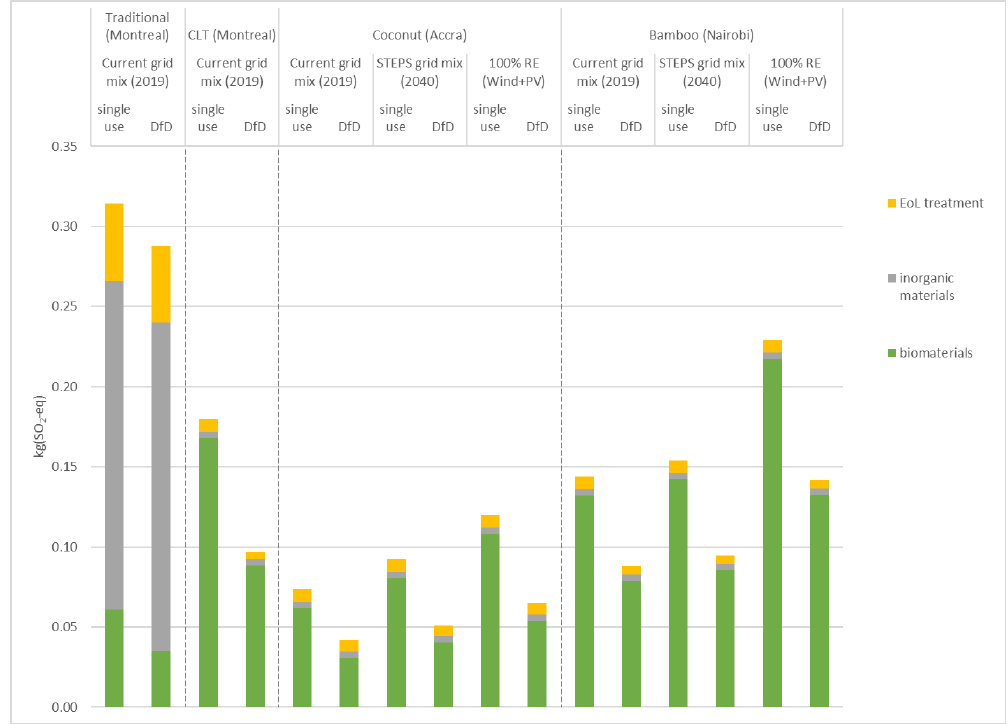
Figure 7. Acidification potential results for the three wall assemblies and locations, with sensitivity analyses (FU = 1 m 2 ).